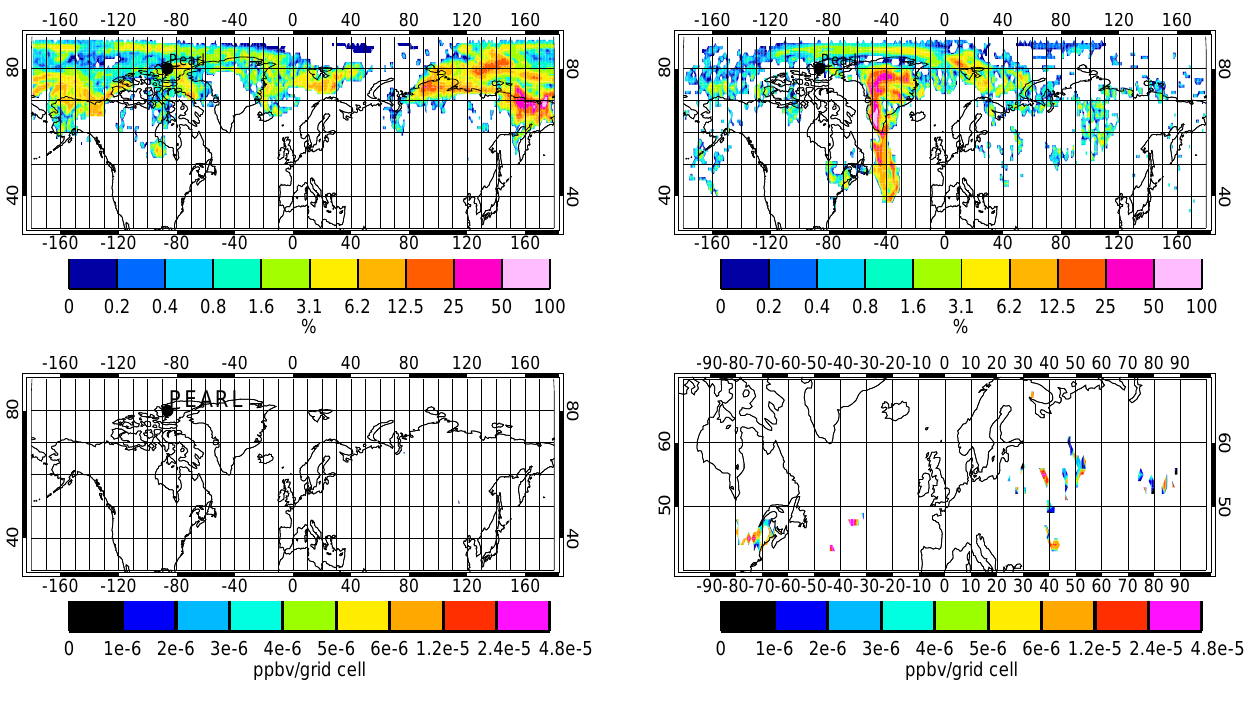
Fig. 9. The top panel shows the footprint residence time distribution for particles arriving at the receptor during the “clean” period from 20 August 2006, 00:00UTC to 23 August 2006, 00:00UTC. The values are expressed as a percentage of the maximum residence time (17.7s) in each grid cell. The corresponding source contributions per grid cell to the mixing ratio at the receptor are shown in the bottom panel.